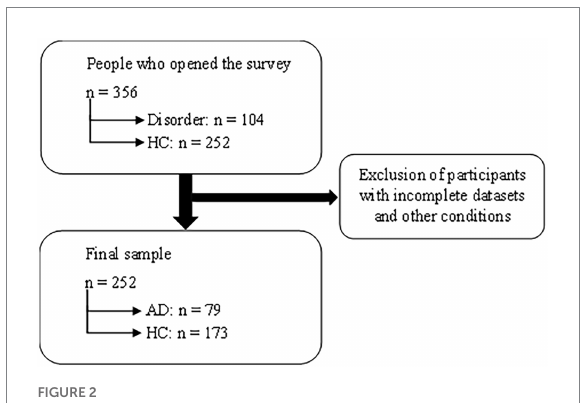
FIGURE 2 Flow chart of the participant selection.